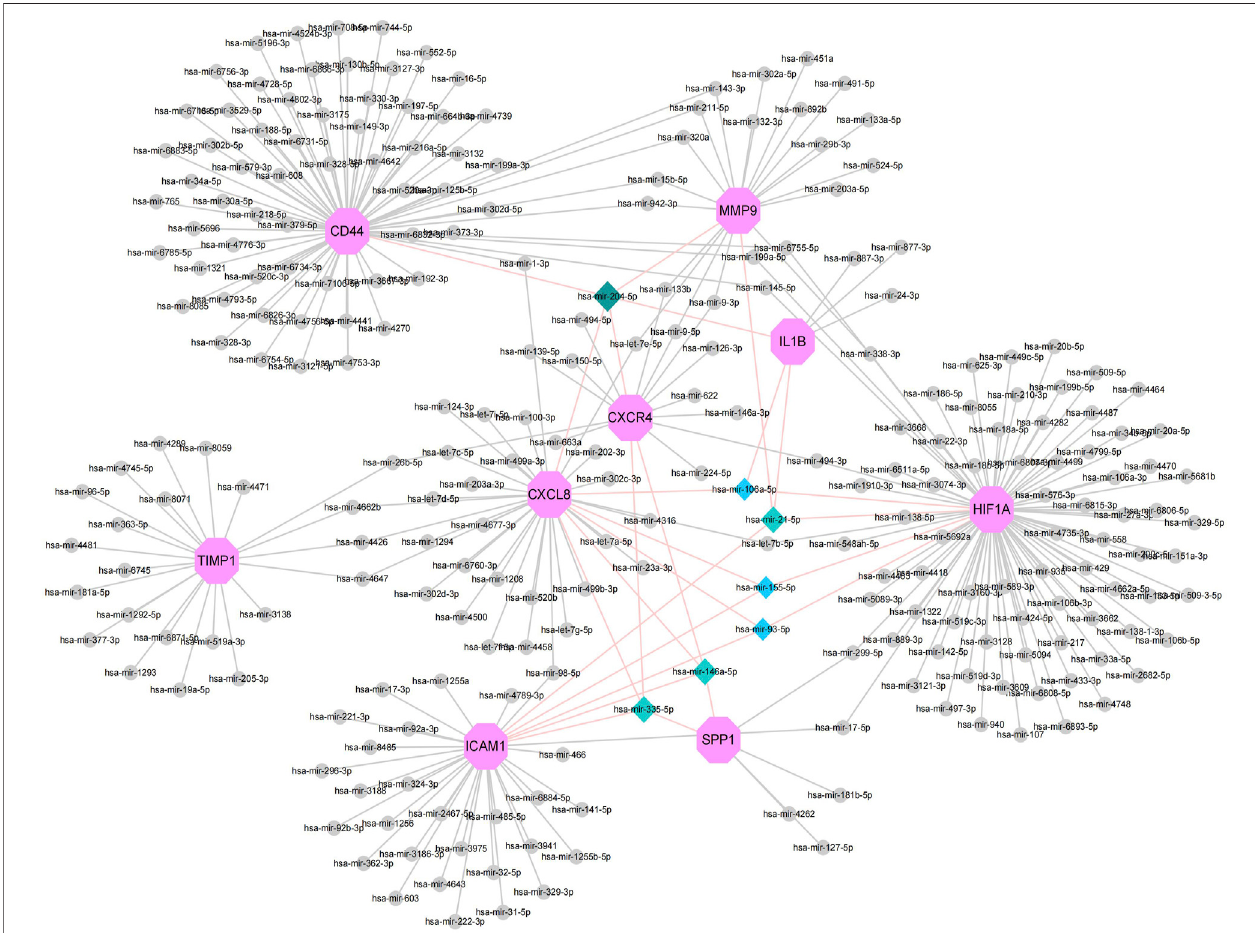
FIGURE 6 | Top 9 hub genes in the integrated miRNA-DEGs network. The pink octagonal shape indicates the 9 hub genes. The gray circles indicate miRNAs with low connective properties to the hub genes. Dark green-light green-light blue diamonds indicate miRNAs with high connective properties to the hub genes.